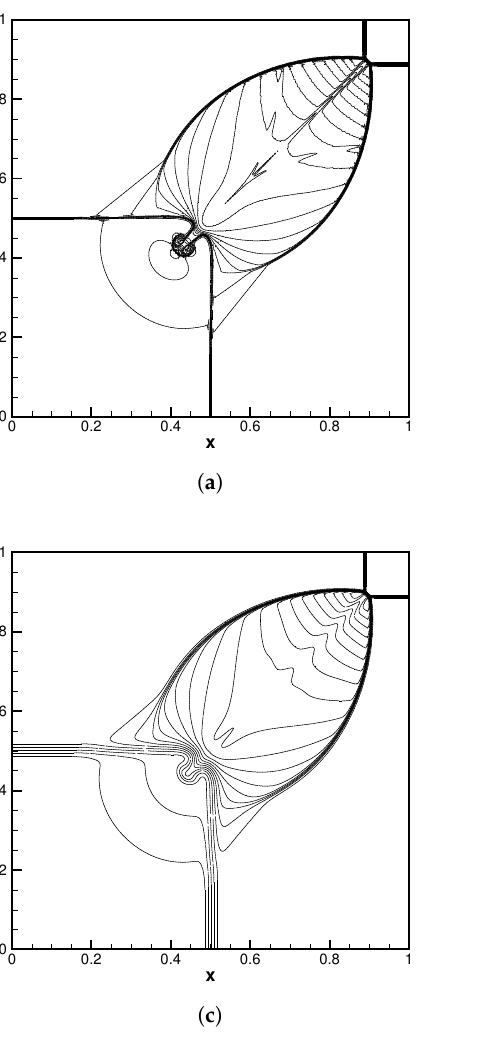
Figure 19. Density solution for the two-dimensional Riemann problem (Case 12) with 160 × 160 P 3 elements at t = 0.25. Thirty-one equally spaced contours from 0.515 to 1.665. ( a ) DB; ( b ) MDH; ( c ) MDA; ( d )